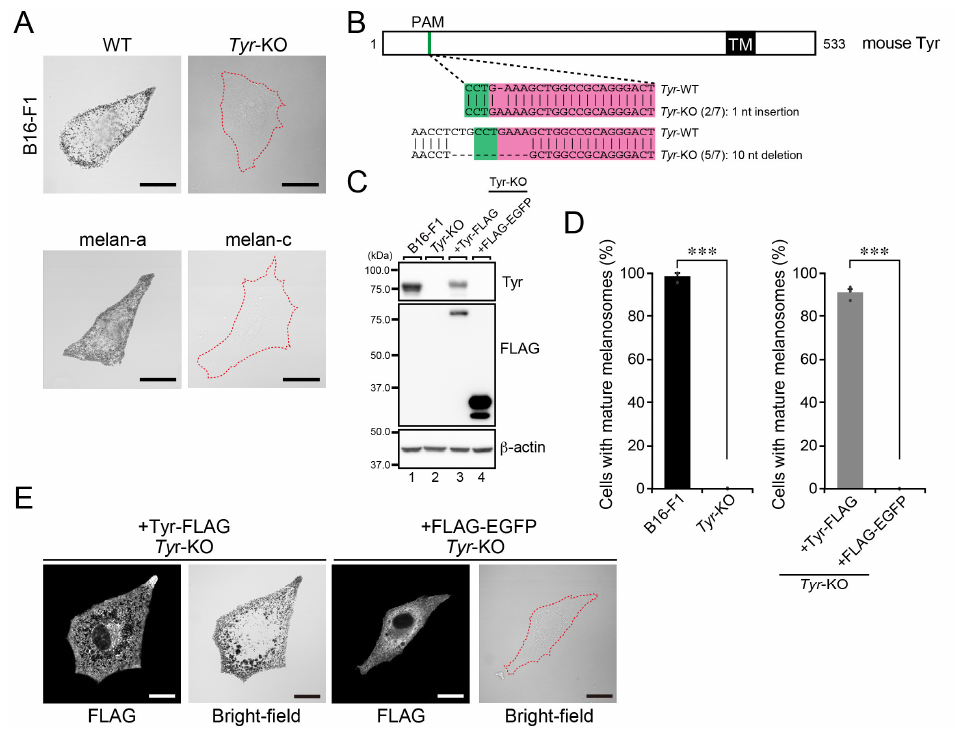
Figure 1. Tyr is essential for the formation of black-pigmented mature melanosomes. ( A ) Representative bright-field images of WT B16-F1 cells, Tyr -KO B16-F1 cells, melan-a cells, and Tyr-deficient melan-c cells. Cells devoid of black-pigmented melanosomes are outlined with broken red lines. Scale bars, 20 μ m. ( B ) Domain organization of mouse Tyr protein and genomic mutations in Tyr -KO cells. The Cas9 target and PAM (protospacer adjacent motif) sequences are highlighted in magenta and green, respectively. Genomic PCR products containing the target site were subcloned into the pGEM-T Easy vector, and then seven colonies (the denominators of the fractions in the parentheses) were picked up at random, and their inserts were sequenced. The numerators of the fraction in parentheses are the numbers of colonies obtained by sequencing the subcloned PCR products. TM, transmembrane domain. ( C ) Expression of Tyr in WT cells and Tyr -KO B16-F1 cells. Lysates of the cells indicated were analyzed by immunoblotting with antibodies against Tyr (top), FLAG tag (middle), and β -actin (bottom). ( D ) Quantification of the numbers of WT cells, Tyr -KO cells, Tyr -KO cells expressing Tyr-FLAG, and Tyr -KO cells expressing FLAG-EGFP containing black-pigmented melanosomes shown in ( A , E ). The graphs show the means and SEM of the data obtained in three independent experiments ( n > 26 cells in each experiment). ***, p < 0.001 (Student’s unpaired t -test). ( E ) Representative bright-field images of Tyr -KO cells expressing Tyr-FLAG or FLAG-EGFP. FLAG-tagged proteins were detected with an anti-FLAG tag antibody. The FLAG-EGFP-expressing cell is outlined with a broken red line. Scale bars, 20 μ m.